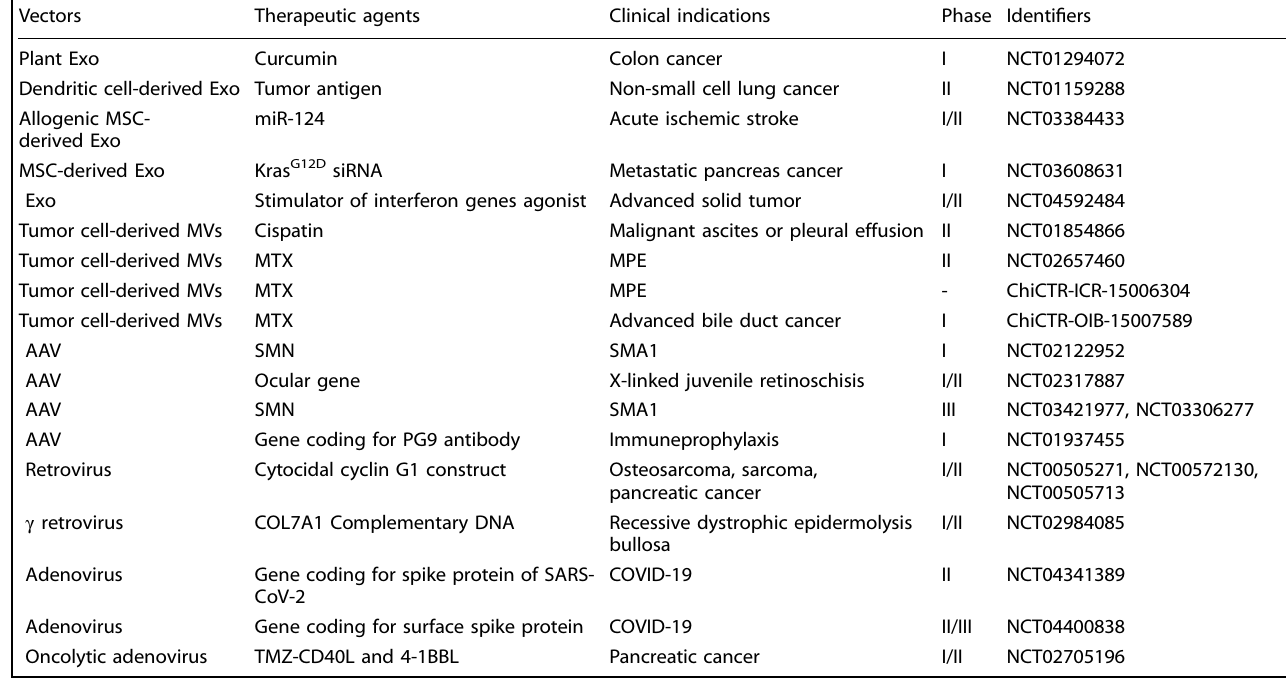
Table 2. Clinical trials of BNPs for human diseases